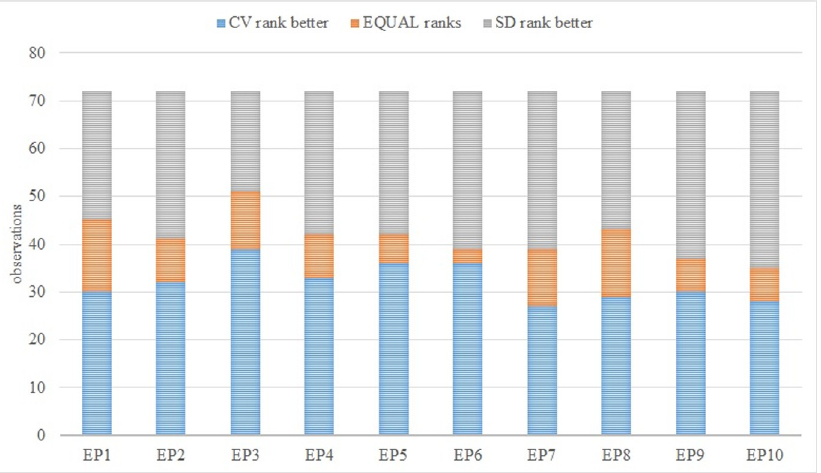
Fig 7. Comparison of the order of individual subjects on the basis of the results of the TOPSIS method (CV vs. SD).